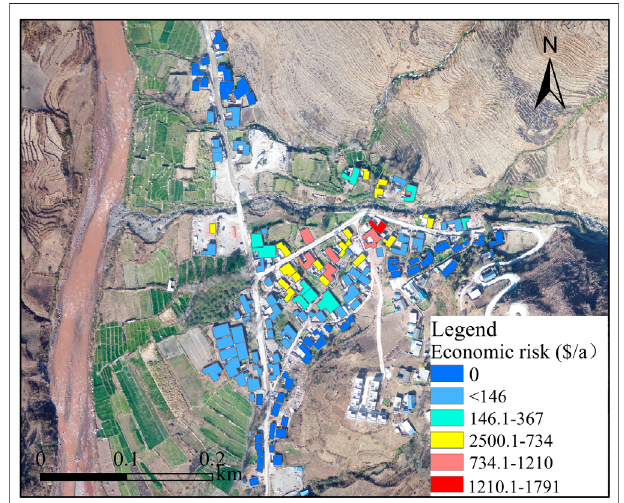
FIGURE 6 | Risk map for buildings in Luomo village.